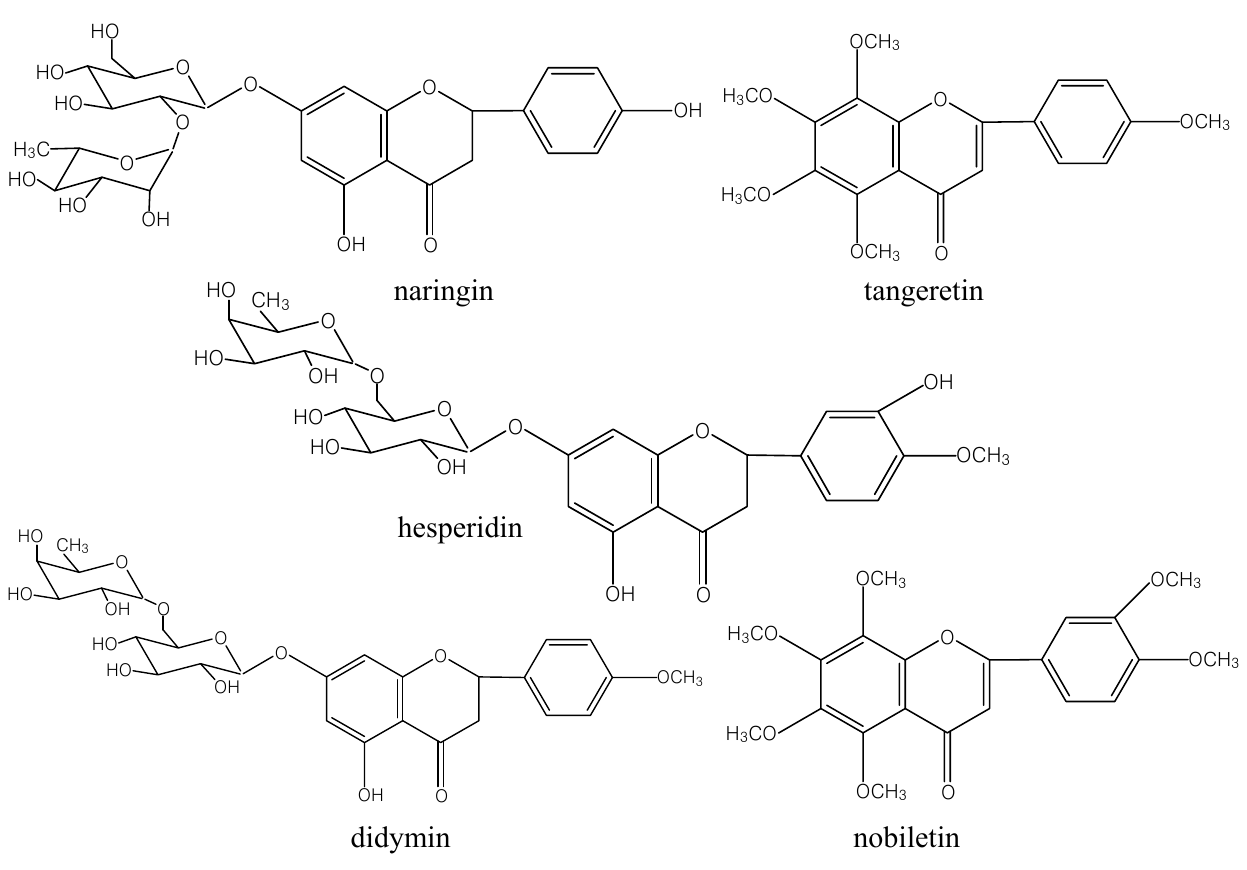
Figure 1. Chemical structures of the five